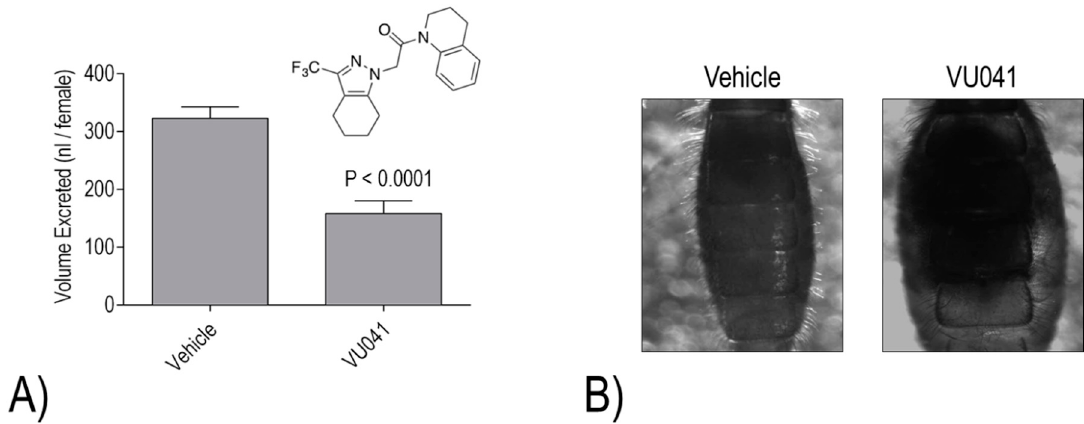
Figure 7. ( A ) Effects of VU041 (structure shown) on the diuretic capacity of adult female mosquitoes ( Ae. aegypti ). The mosquitoes were topically-treated with a sub-lethal dose of VU041 (1.6 µ g/mg mosquito) 2 h prior to injection of their hemolymph with 900 nL of PBS. Mosquitoes treated with the vehicle (50% acetone/50% ethanol) served as controls. The amount of urine excreted within one hour of injection was measured. Values are means ± SEM. ( B ) Representative images of the abdomens of adult female An. gambiae 24 h after a blood meal. The mosquitoes were treated with a sub-lethal dose of VU041 (1.0 µ g/mg mosquito) within 30 min after engorgement. Mosquitoes treated with the vehicle (95% ethanol) served as controls. Data and images are from [23].